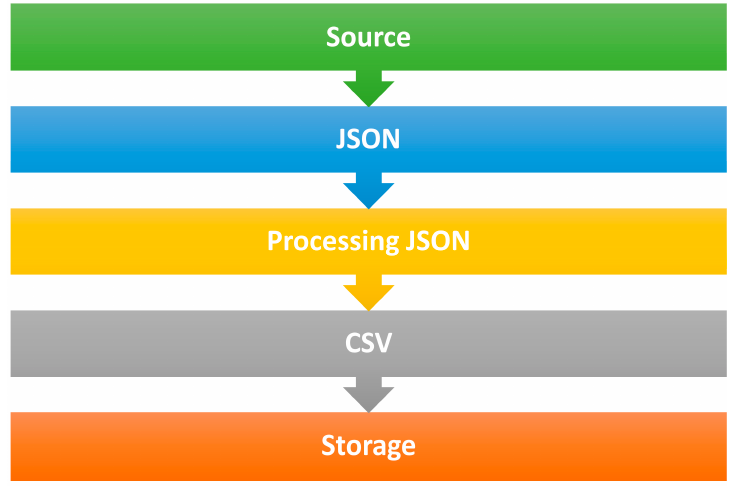
Figure 3. Data process flow diagram.